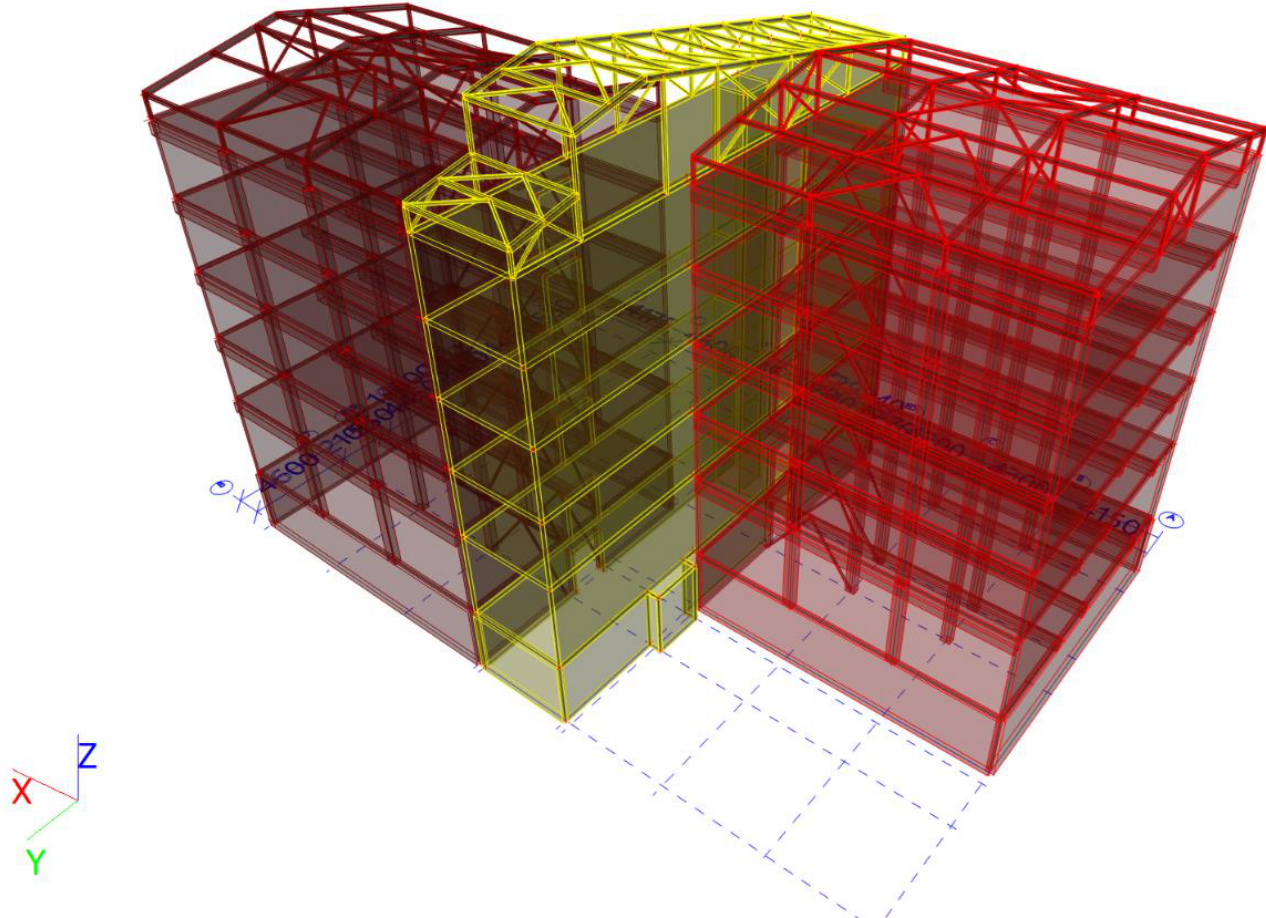
Figure 17. Numerical FEM model of the case study building (each section is colorized differently).